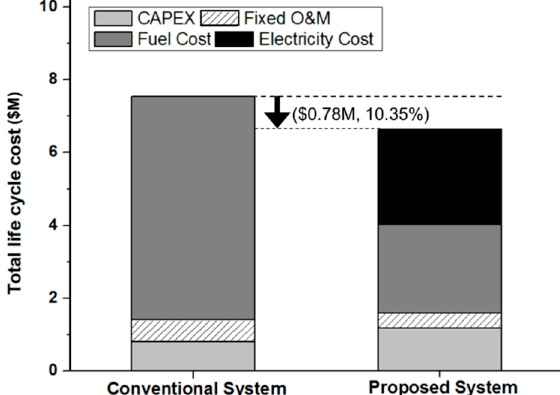
Figure 13. Total life cycle costs for conventional and proposed systems based on present values (25 years; i = 5%; a, b, c = 2%; electricity cost = 9.2 cents/kWh). Figure 12. Cumulative saving costs for the lifespan of a ship depending on each variation.